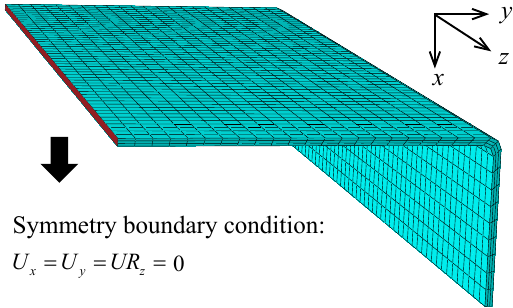
Figure 5. The established finite element model.